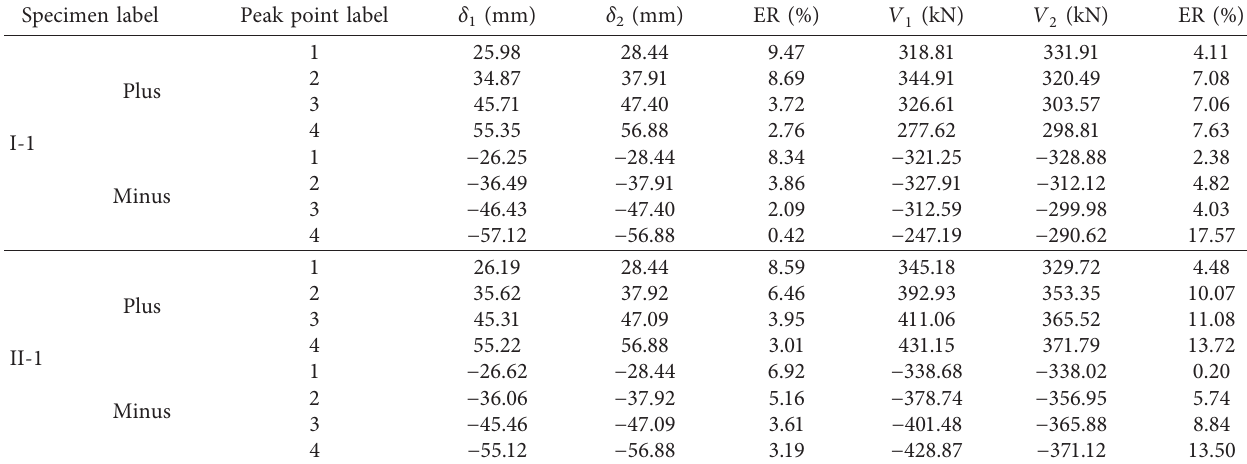
Figure 17: Comparison on failure modes of some pseudostatic specimens. (a) Specimen I-1. (b) Specimen III-1. Table 4: Comparison on peak point data of pseudostatic